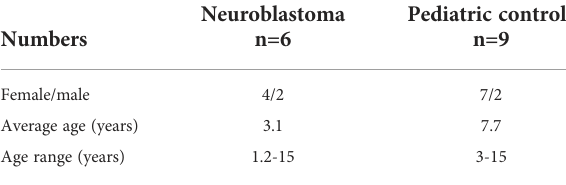
TABLE 1 Summary of patients and